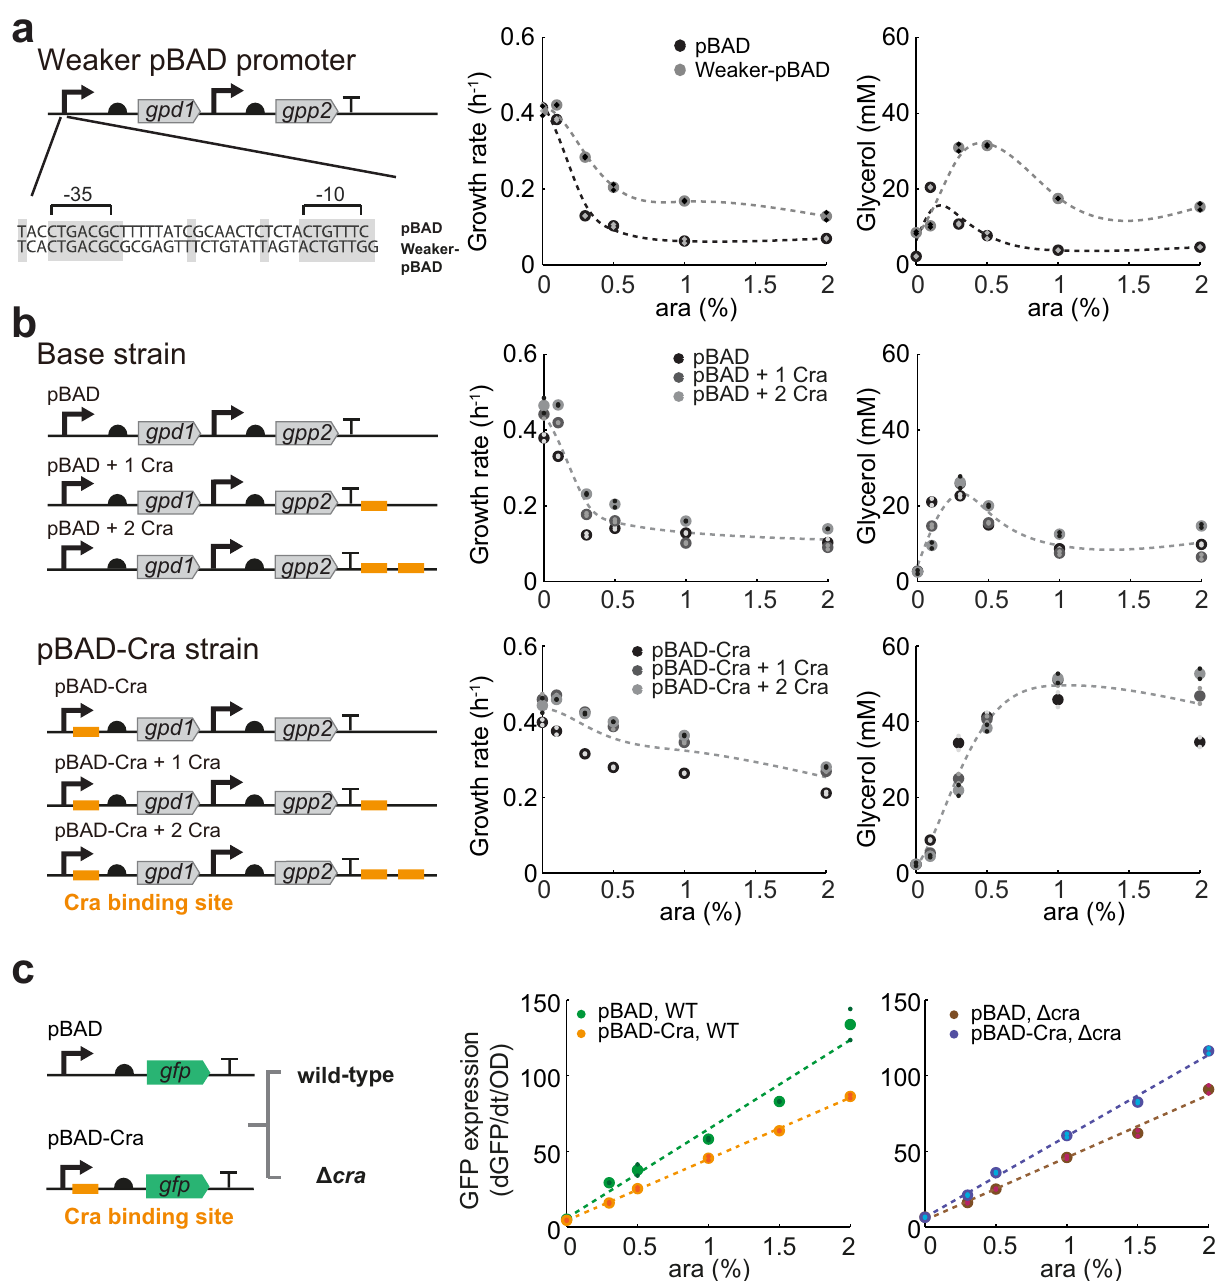
Fig. 4 Alternative strategies to engineer the pBAD promoter. a The pBAD promoter was mutated between the − 35 and − 10 boxes 25 . The pBAD promoter in the base strain (Fig. 1a) was replaced with the mutated pBAD promoter and cultured in 96-well plates. Growth was measured in a plate reader at different induction levels of GPD1 (0, 0.1, 0.3, 0.5, 1, and 2% ara). Glycerol in the medium was measured after 24 h. Growth rates were determined by regression analysis between 5 and 10 h. Small dots show data from n = 2 plate reader cultures and big dots are the mean. b Same as a , for strains expressing gpd1 with engineered pBAD promoters that have 0 to 3 Cra-binding sites inserted at different positions. The position of Cra-binding sites is indicated in orange. c GFP plasmids with or without Cra-binding site were expressed in the wild-type (WT) or the Δ cra strain. ( n = 2, pBAD, WT is the same as in Fig. 1b). Source data are provided in the Source Data fi